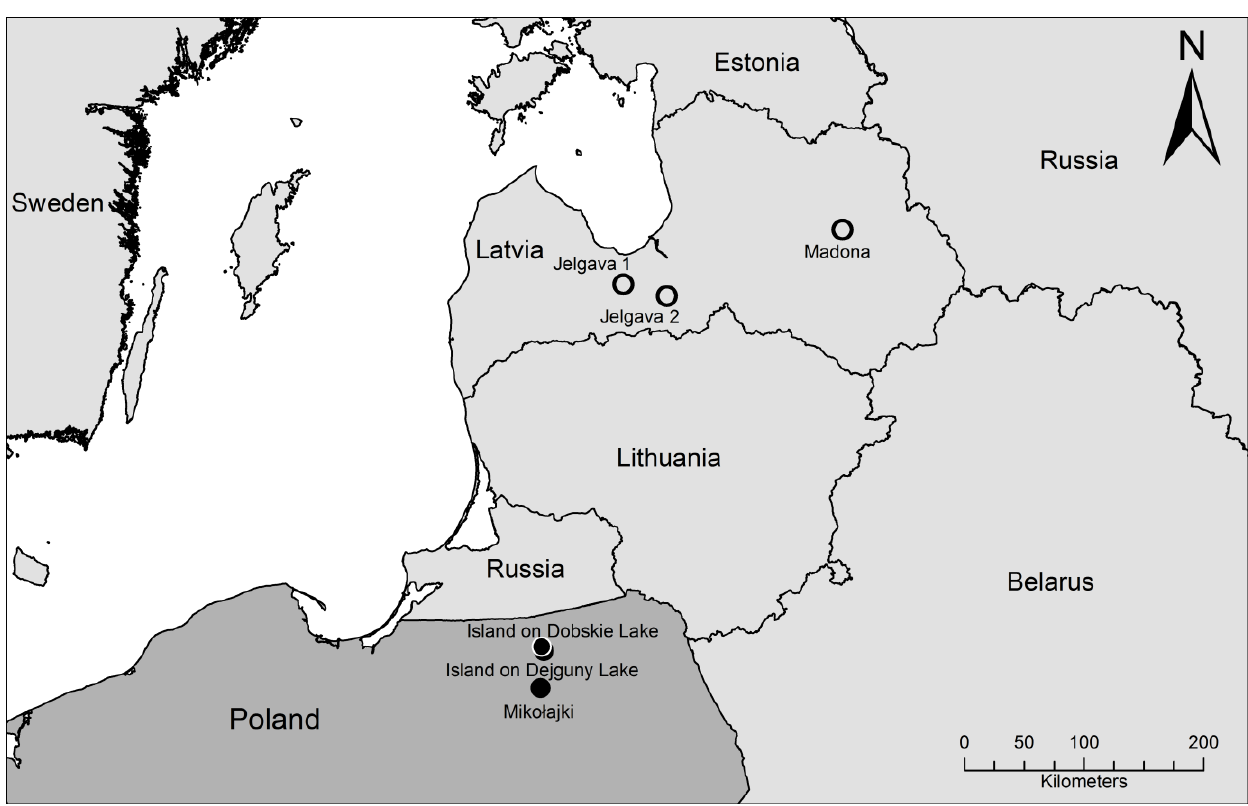
Figure 1. Map of the north-eastern part of Poland and the surrounding countries showing the three trapping sites of bank voles in Poland described here and the three localities in Latvia where related PUUV sequences were detected